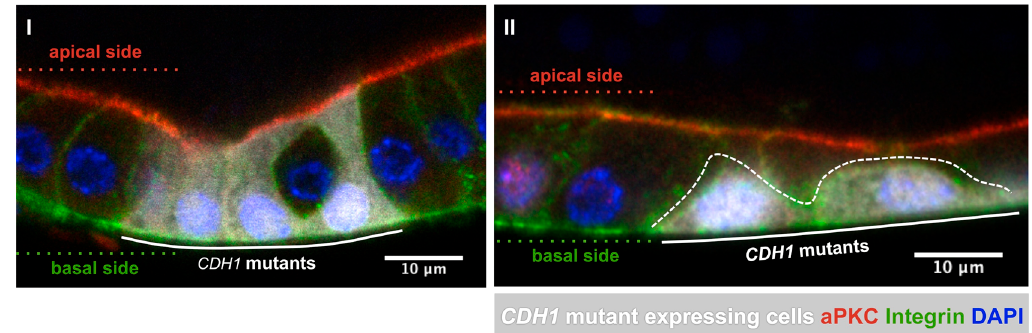
Figure 5. Expression of human CDH1 mutants in the Drosophila follicular epithelium and their effects on tissue organization. ( I ) The expression of CDH1 mutants promotes the disruption of epithelial organization, inducing epithelial invagination; ( II ) Cell extrusion from the monolayer occurs through loss of contact with the apical surface of the tissue. Staining is as follows: DAPI labels the nuclei, aPKC in red delineates the apical side, whereas integrins are labelled in green. Mosaic expression of CDH1 (labelled in white) enables direct comparison between wild-type and genetically manipulated clones. The original data in Drosophila heighten the potential of novel strategies to evaluate CDH1 missense variants in the context of HDGC.